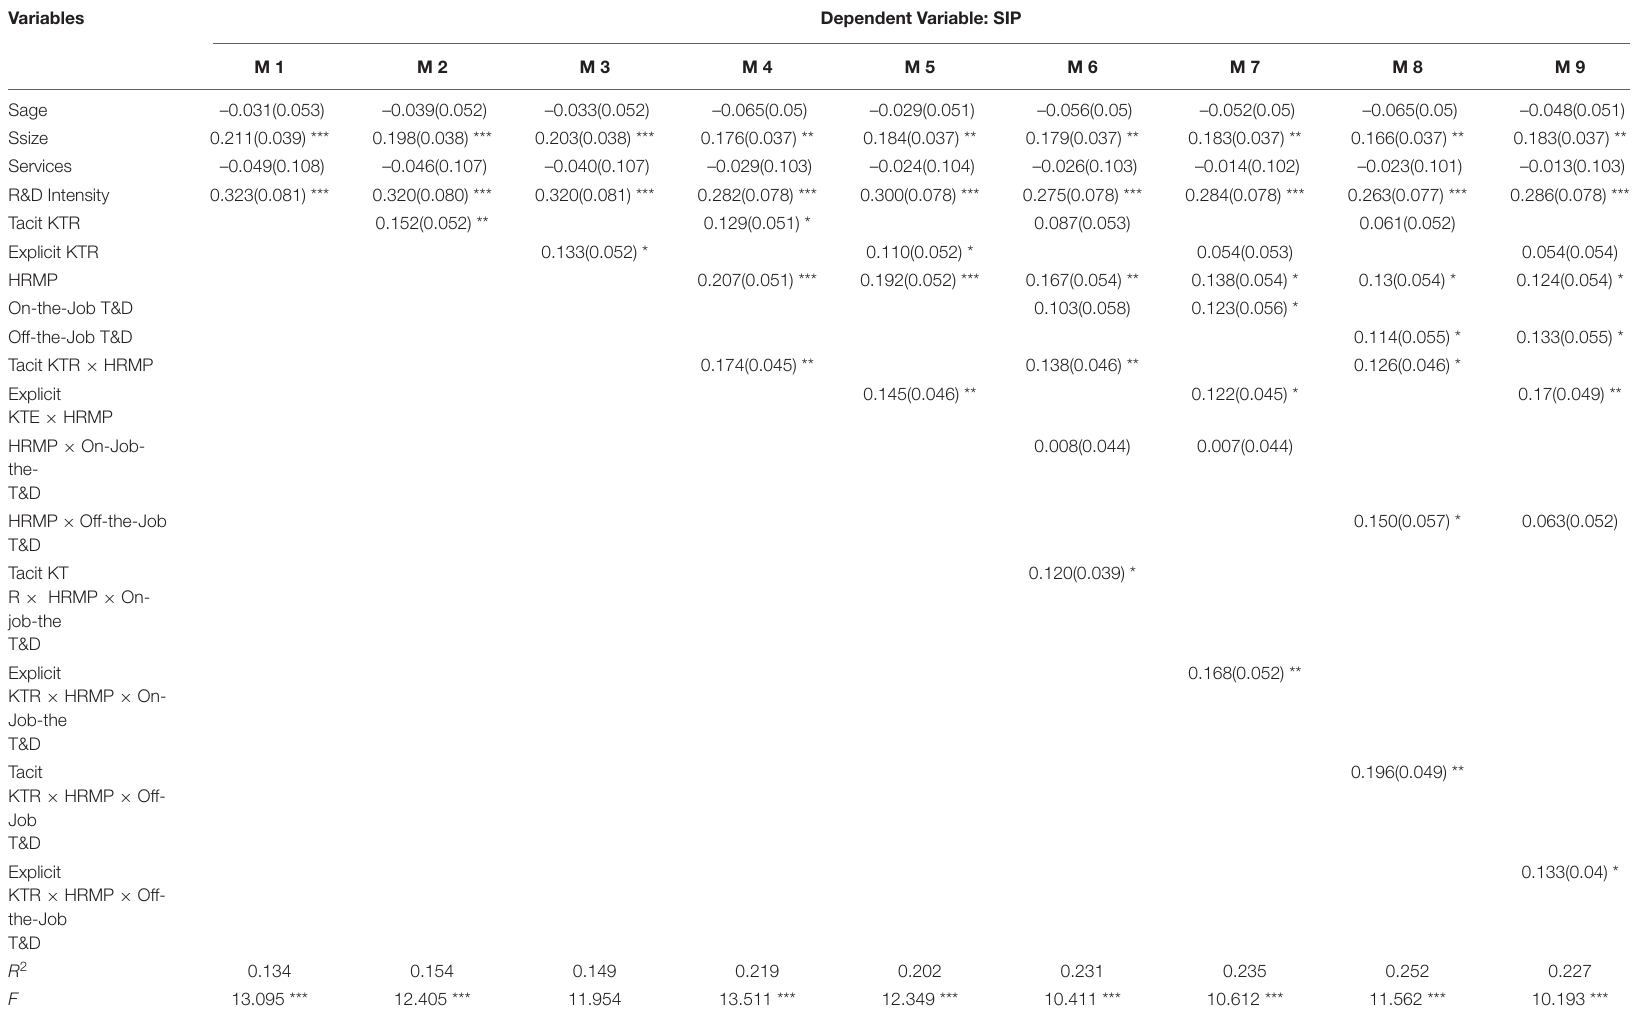
TABLE 3 | Results of the hierarchical linear regression of